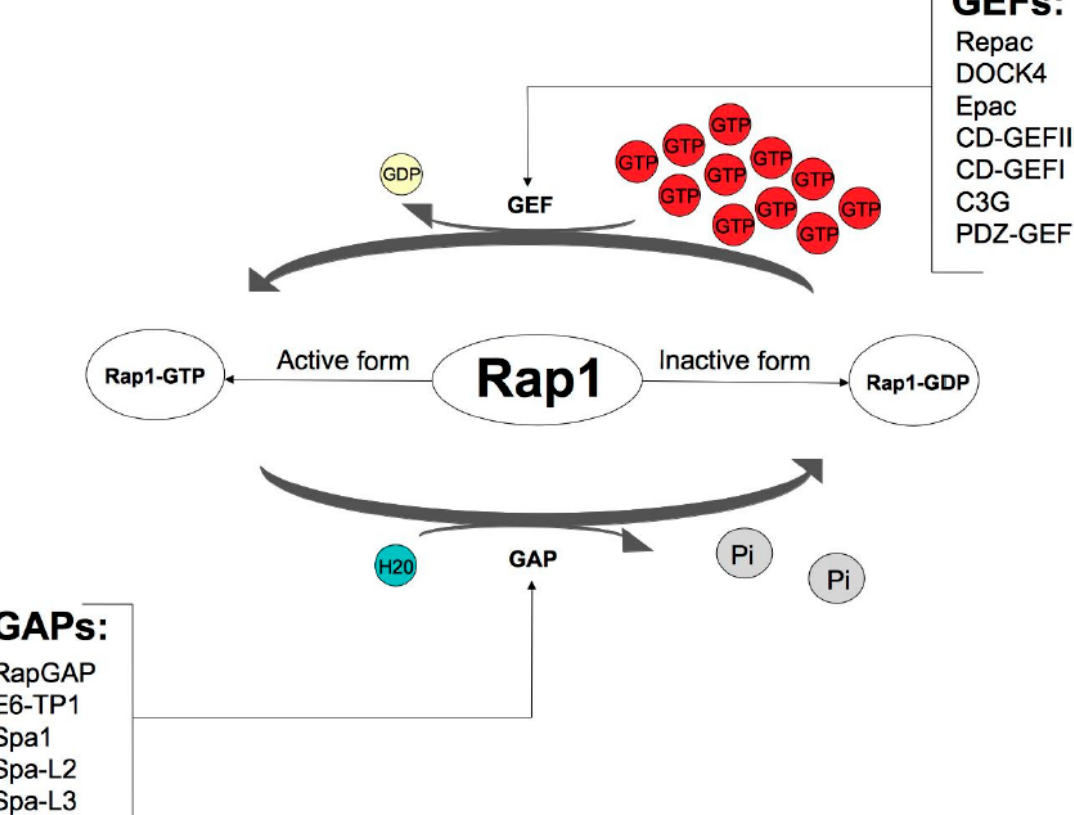
Figure 1. Control of Rap1 GTPase activity via guanine nucleotide exchange factors (GEFs) and GTPase-activating proteins (GAPs). Based on the KEGG Kanehisa Laboratories (https://www.kegg.jp/kegg-bin/show_pathway?map04015, accessed on 19 September 2018).